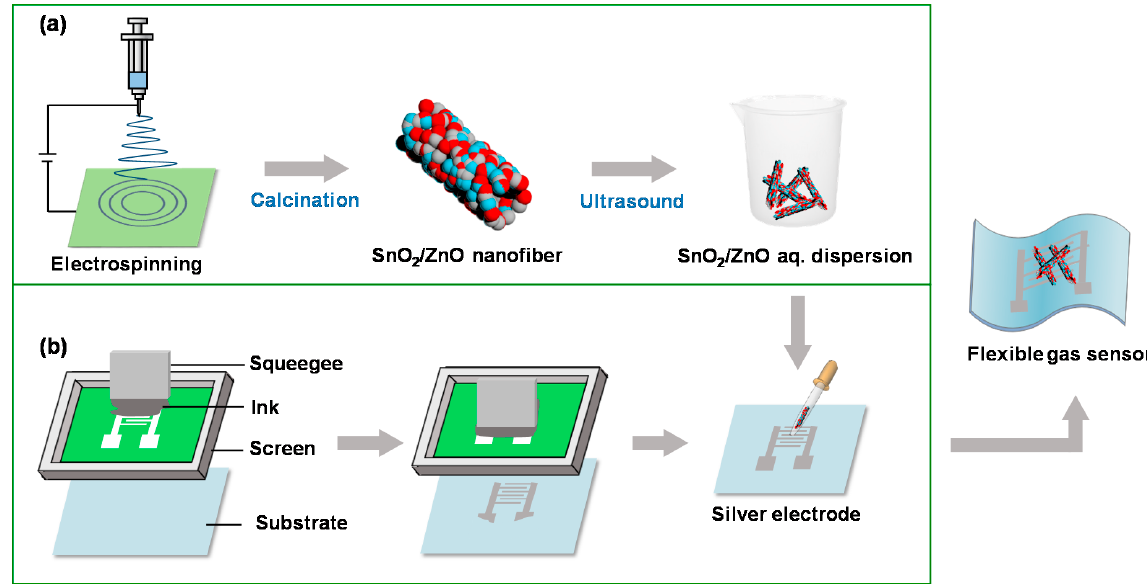
Figure 1. ( a ) Schematic diagrams of the preparation process of SnO 2 /ZnO composite nanofibers by electrospinning. ( b ) Fabrication process of flexible electrodes by screen printing with silver paste on substrates.